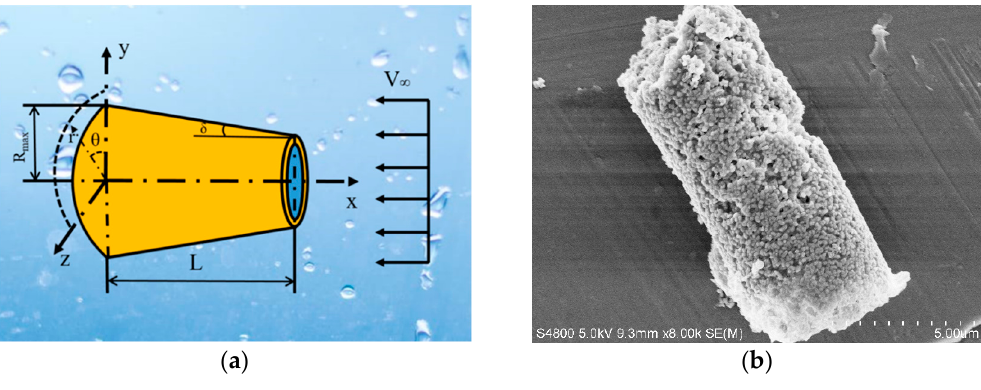
Figure 1. Schematic and SEM image of the